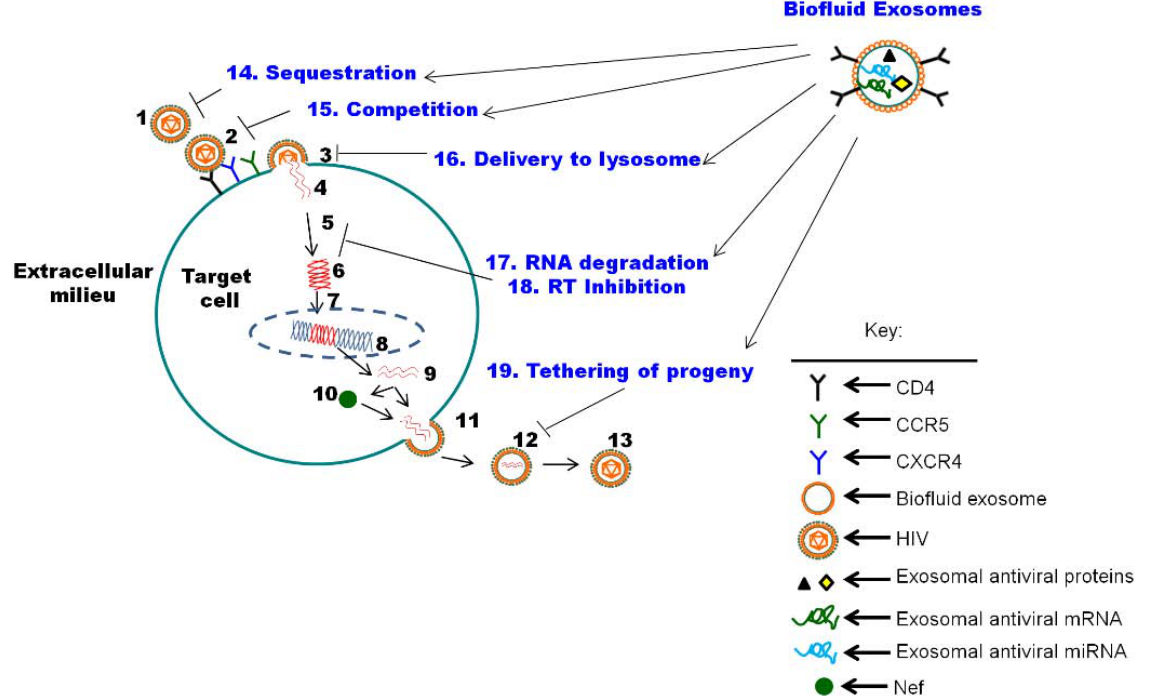
Figure 2. Model of biofluid exosome antiviral functions within the HIV-1 life cycle: ( 1 – 13 ) HIV-1 life cycle as defined in Figure 1 legend. Biofluid exosomes may interact with free HIV-1 and ( 14 ) sequester free viral particles within exosome aggregates thereby inhibiting HIV-1 infection by preventing virus from binding to target cells.